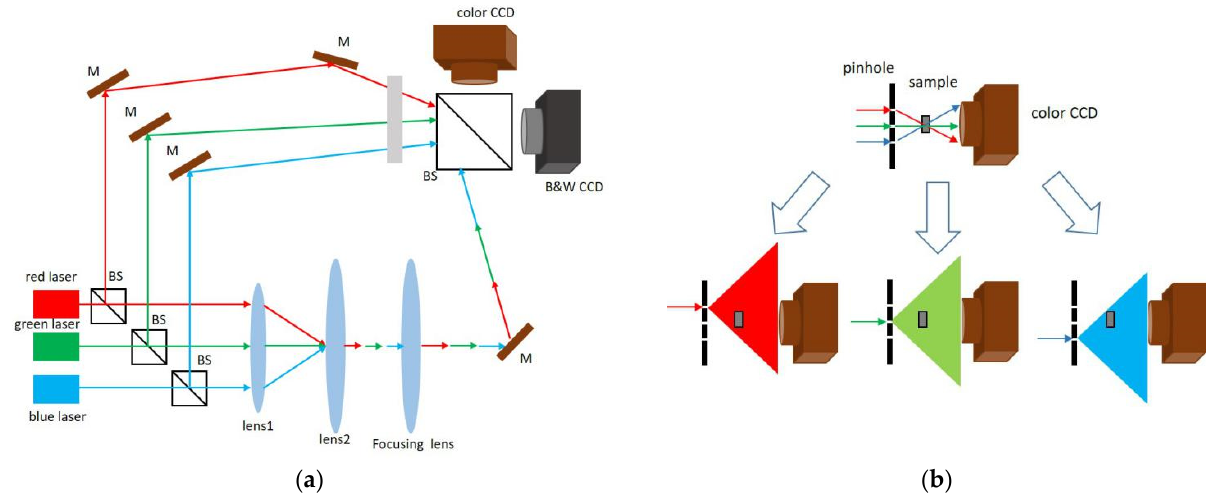
Figure 9. Schematic diagrams of single-exposure super-resolved interferometric microscopy. ( a ) Sin- gle-exposure super-resolved interferometric microscopy with one detector, adapted from [65]. ( b ) Single-exposure super-resolved interferometric microscopy with three detectors, adapted from